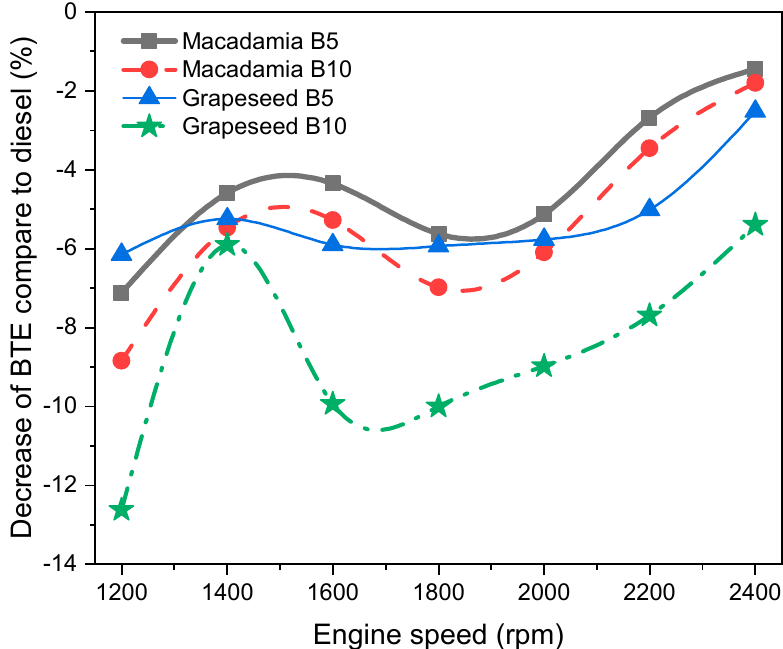
Figure 4. E ff ect of B5 and B10 biodiesel blends on brake thermal e ffi ciency BTE compared to Figure 4. Effect of B5 and B10 biodiesel blends on brake thermal efficiency BTE compared to diesel.